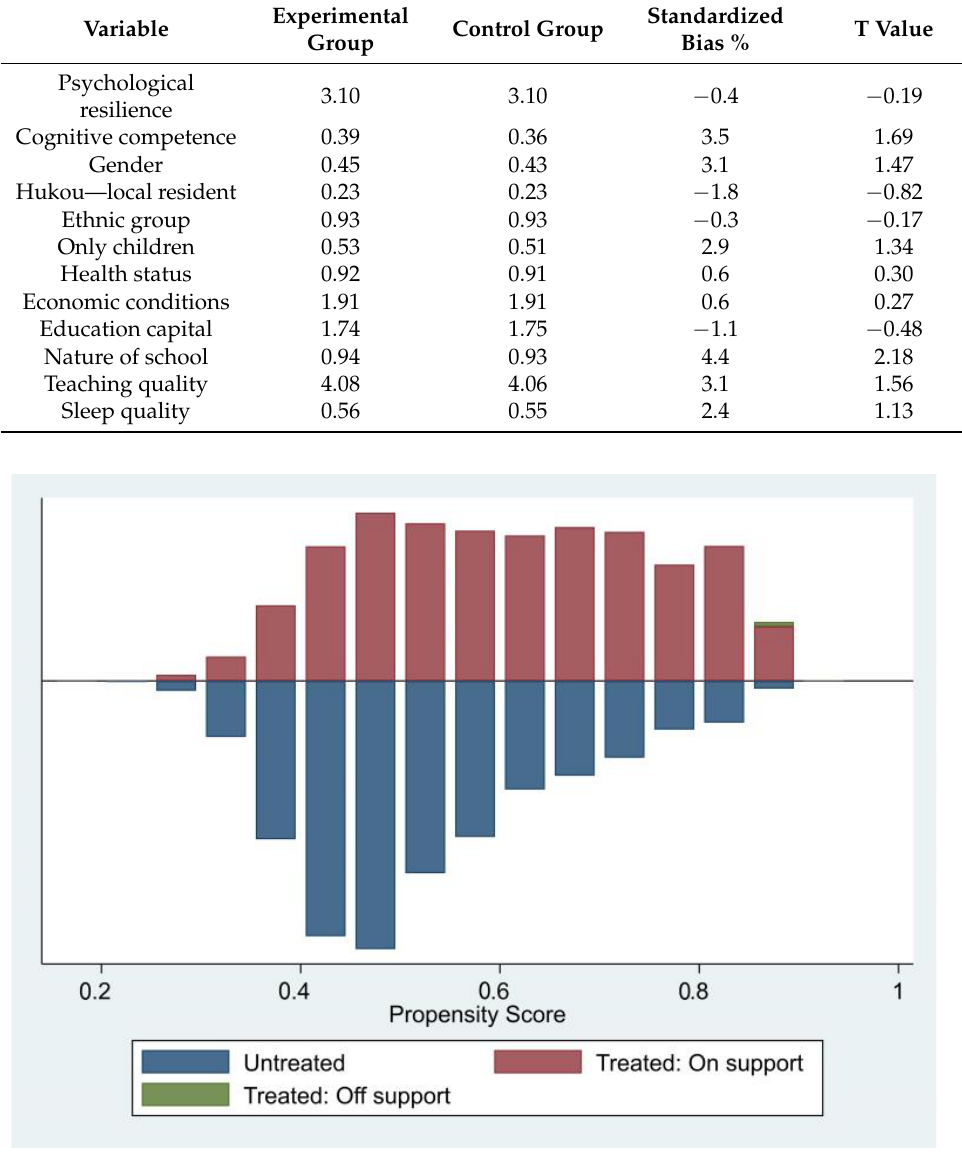
Figure 4. Common value range of propensity score (on and off support). To produce more reliable PSM results, we calculated the data with one-to-one match- Table 5. Sample balancing test (on and off support). ing, radius matching, kernel matching, and nearest neighbor matching. The ATT values calculated are shown in Table 6. Before matching, ATT = 17.12 and T = 13.34 ( p < 0.01). With one-to-one matching, ATT = 5.36 and T = 3.05 ( p < 0.01). With radius matching, ATT = 16.80 and T = 12.88 ( p < 0.01). With kernel matching, ATT = 4.77 and T = 3.20 ( p < 0.01). With nearest neighbor matching, ATT = 5.36 and T =2.75 ( p < 0.01). Evidently, the matched ATT values are lower than that before matching and reach the significance level of 1%. To sum up, although the ET-AP effect before matching is overestimated, it is still significant. In other words, H1a is tenable. However, the ETI-AP correlation and its effect mechanism should be further